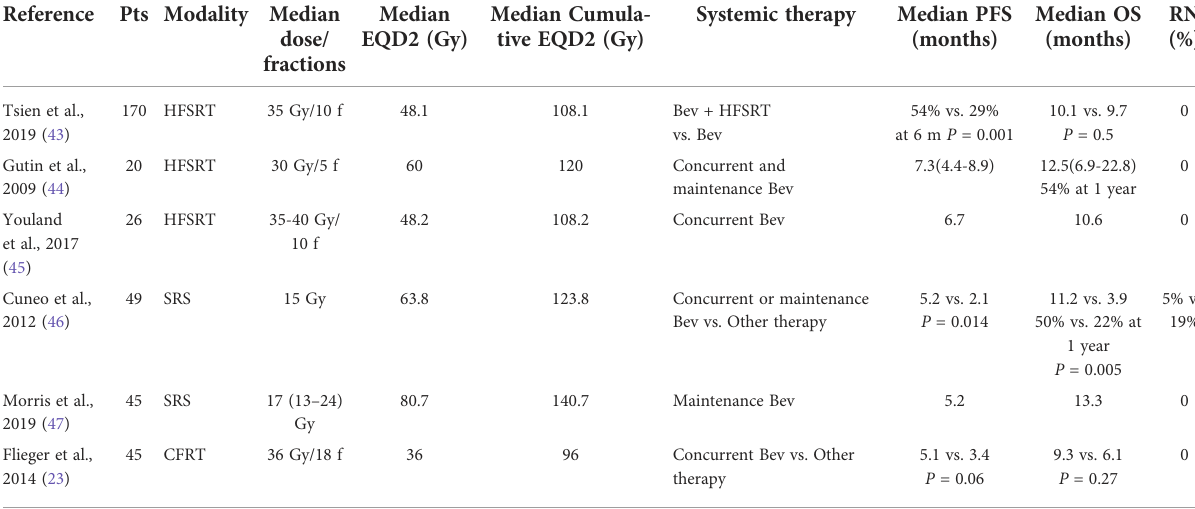
TABLE 5 Re-irradiation combined with bevacizumab for recurrent glioblastomas: literature review.